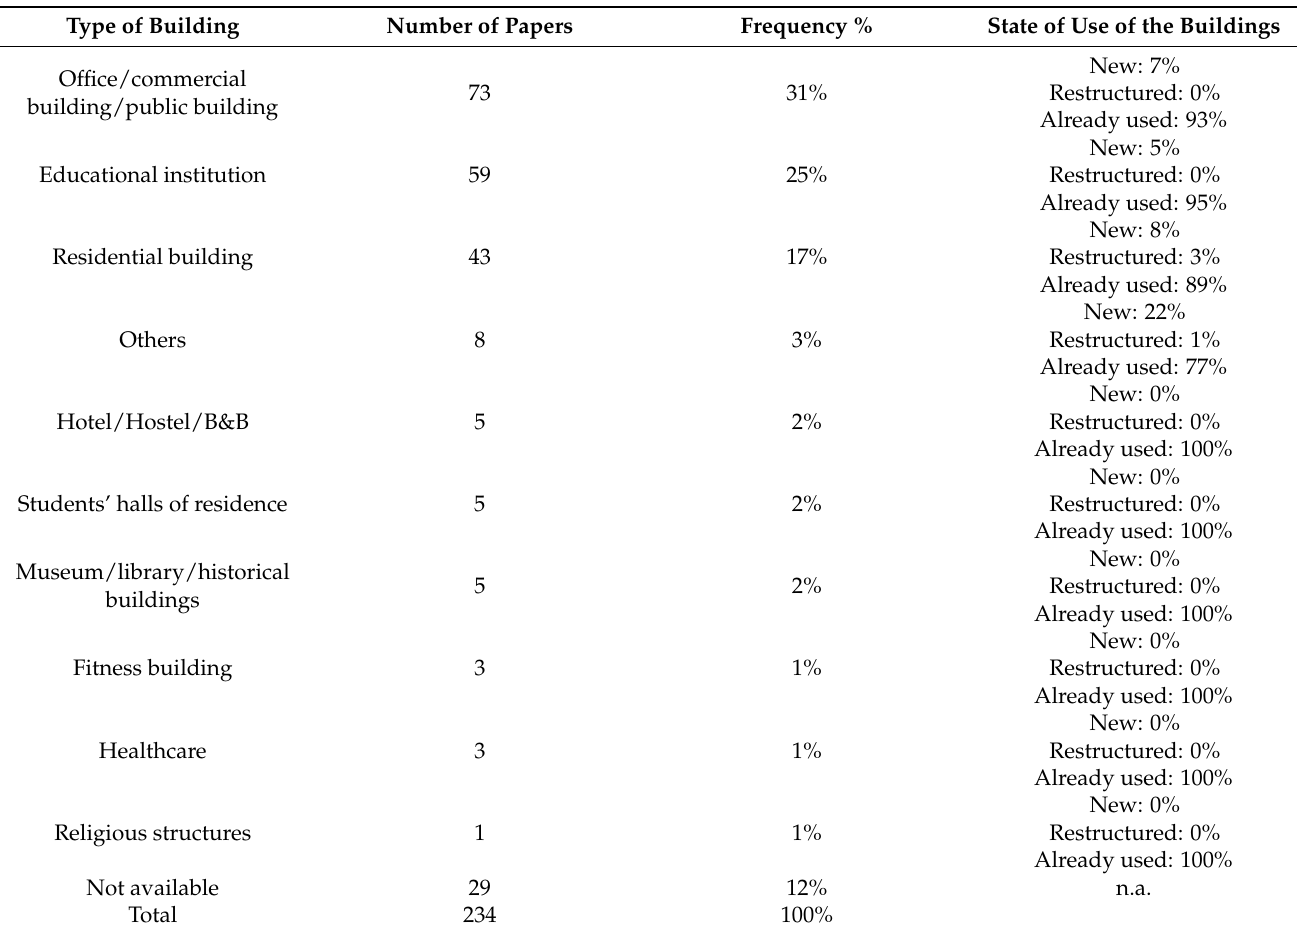
Table 3. Type of building